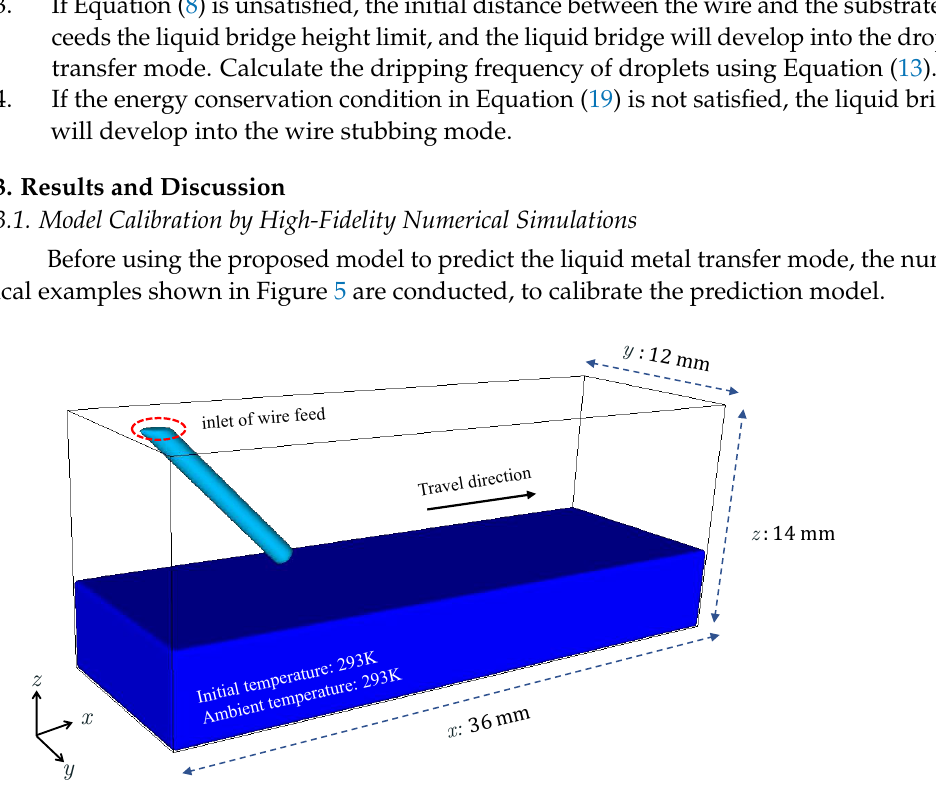
Figure 5. High-fidelity numerical model used for calibration of the prediction model. In this case, x , y , and z are the travel, the transverse, and the height directions, respectively. The size of the calculation domain is 3.6 cm × 1.2 cm × 1.4 cm. The material used for both substrate and wire is mild steel, with its material parameters [33,34] listed in Tables 1 and 2. The thermal conductivity and specific heat capacity are temperature- dependent and are linearly interpolated from the values listed in Table 2, while other parameters remain